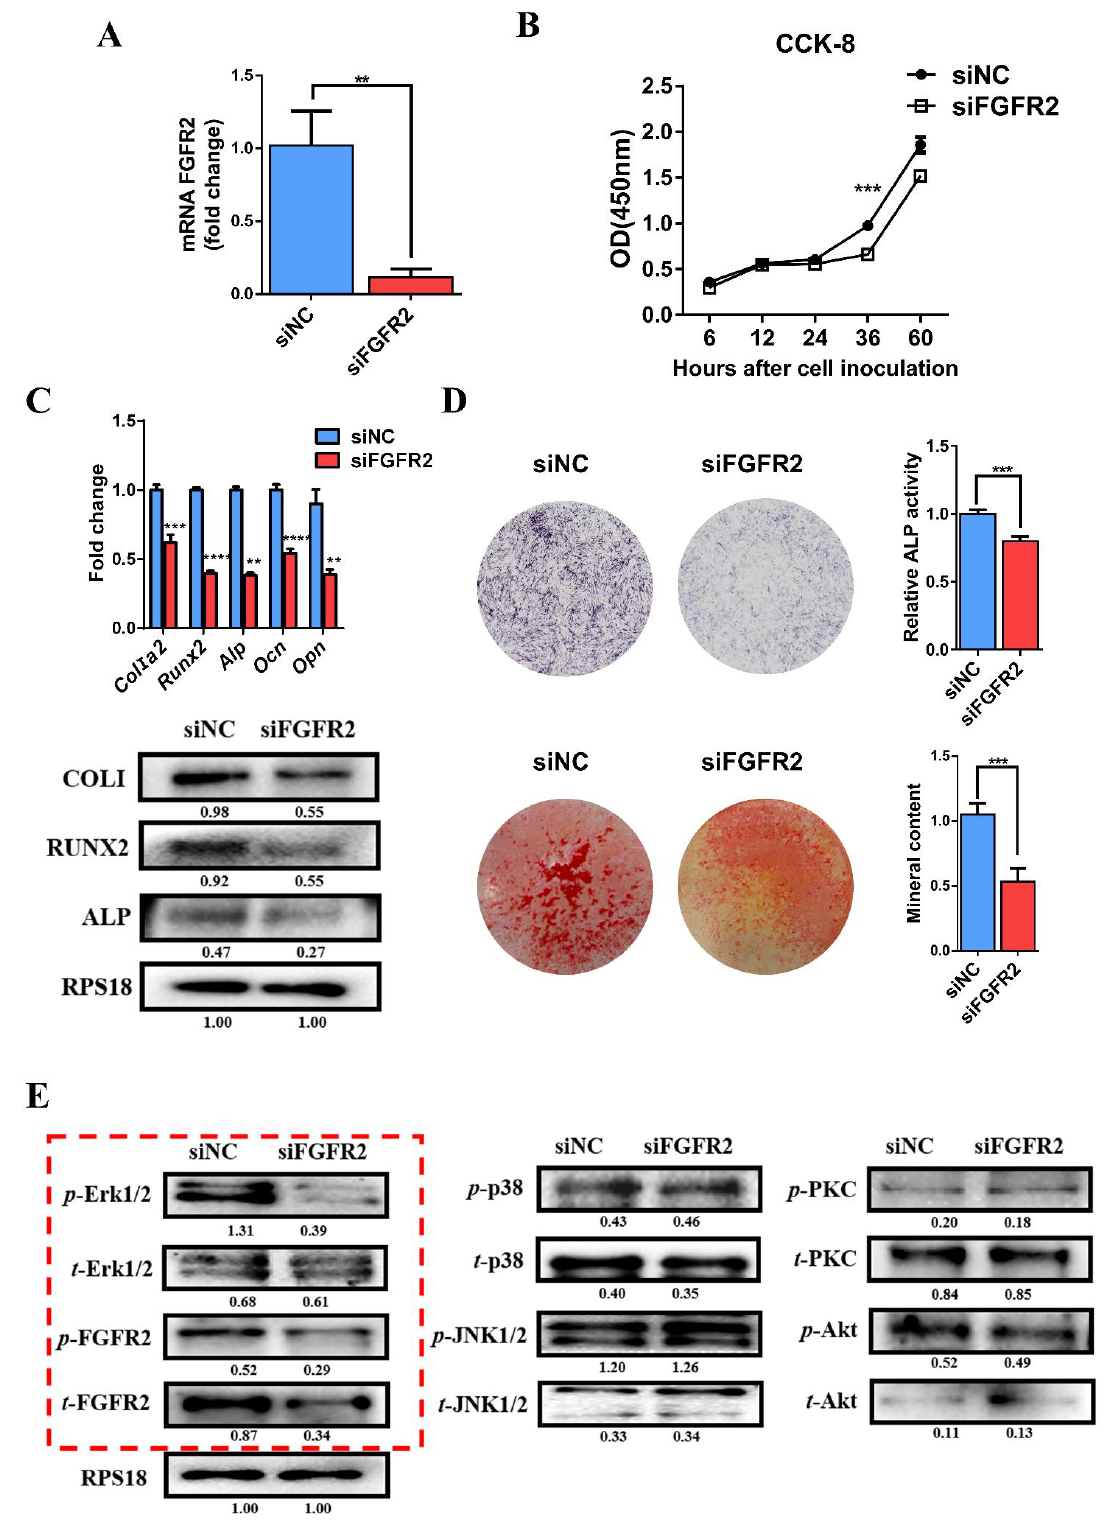
Figure 3. Knockdown of FGFR2 induced by siRNA-inhibited osteogenic differentiation by decreasing Erk1/2 MAPK activation: ( A ) qRT-PCR assay showed mRNA FGFR2 expression after transfection with siRNA against FGFR2. ( B ) CCK-8 assays were carried out to assess cell proliferation.